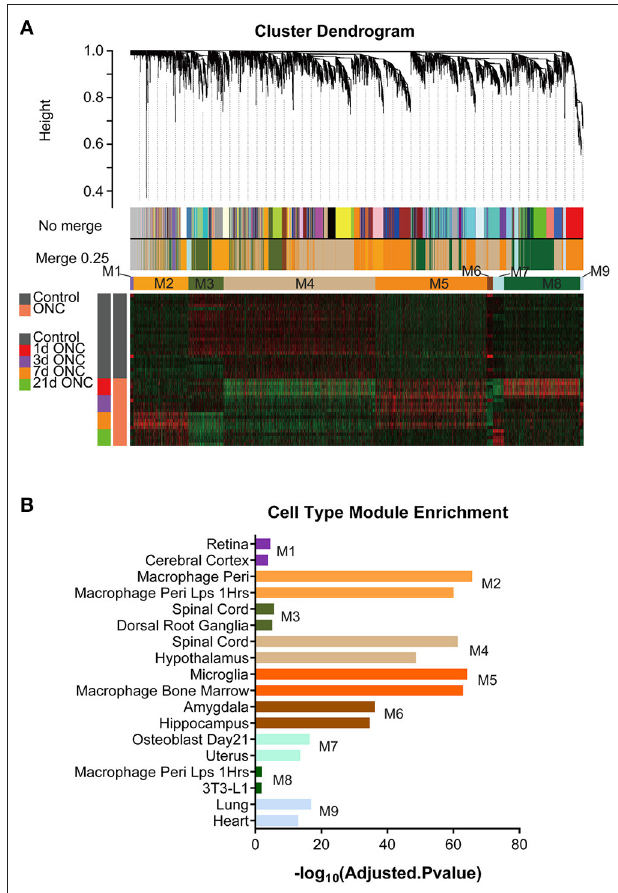
FIGURE 3 | WGCNA of all 45 ONH samples identified gene modules. (A) With 5,323 time-course-related genes, a hierarchical cluster dendrogram of 45 ONH samples identified coexpression modules. Modules corresponding to the branches are labeled with different colors indicated by the color bands below the tree. Nine gene modules were generated after 0.25 threshold merging. (B) Cell type enrichment analyses for the 9 modules. The two most enriched cell type terms for each module are shown. ONH, optic nerve